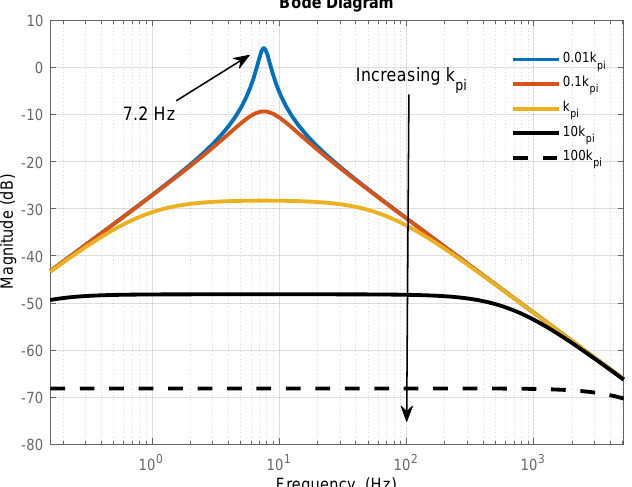
Figure 11. Sensitivity of Output Admittance Y oc , i ( s ) to k pi in increasing order of 0.01 × , 0.1 × , 1 × , and= 10 × k pi (base case).